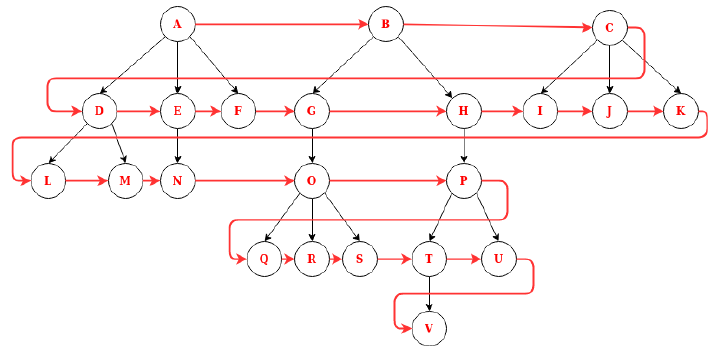
Figure 2. Traversal On Levels.